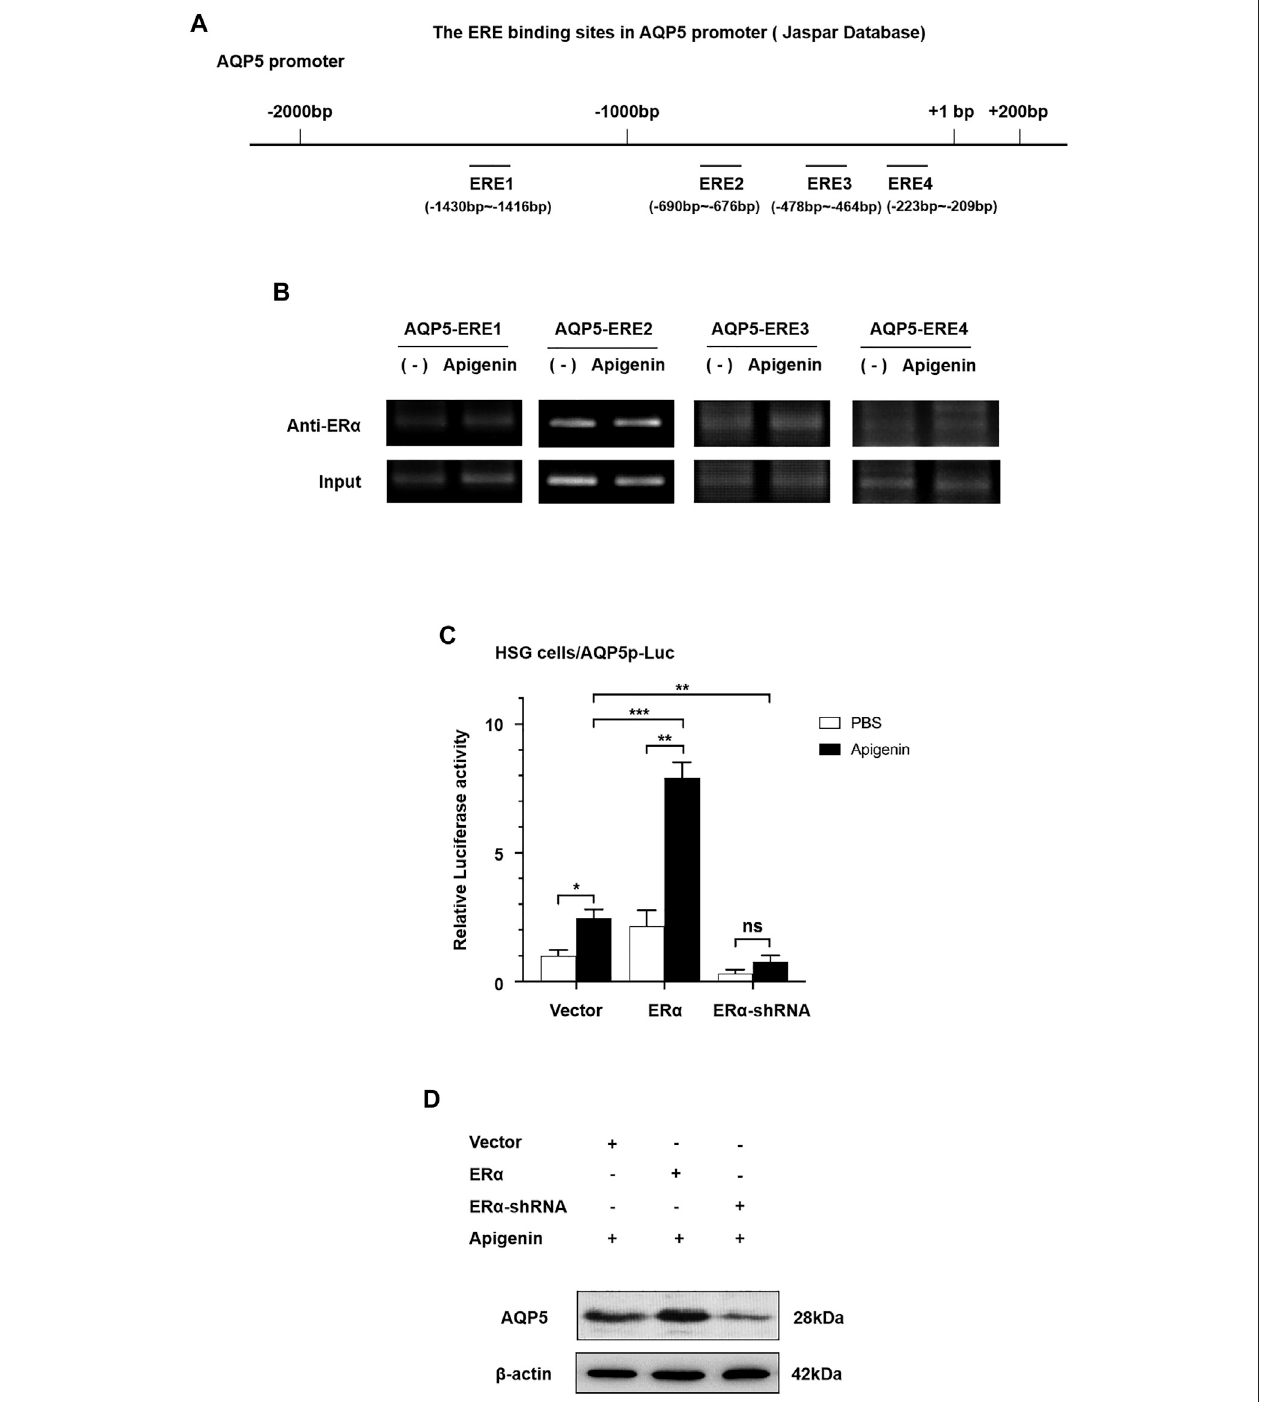
FIGURE 3 | Apigenin upregulates the transcription and translation of AQP5 through the ER α pathway. (A) Scheme showing AQP5 promoter sequence with ER α bindingsites. (B) ChIPresultsshowedthatER α occupancywasapparentlyincreasedatERE3inthepresenceofapigenin. (C) Relativeluciferaseactivity(theindicationof AQP5 expression) in ER α -overexpressed and -knocked down with or without 1 μ M apigenin in HSG cells. (D) Western blot analysis showing the effect of apigenin treatment onAQP5protein expression in ER α -overexpressed and -knocked down HSG cells. Dataare presented asthe mean ±SD, n = 3.Signi fi canteffect ofthe treatment, * p < 0.05, ** p <